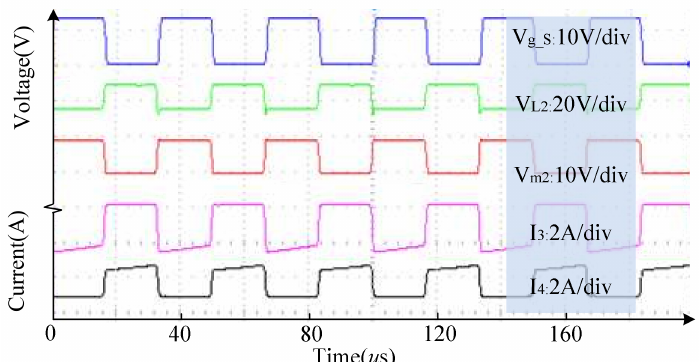
Figure 10. The voltage and current waveforms of tapped inductor L 2 during the balancing